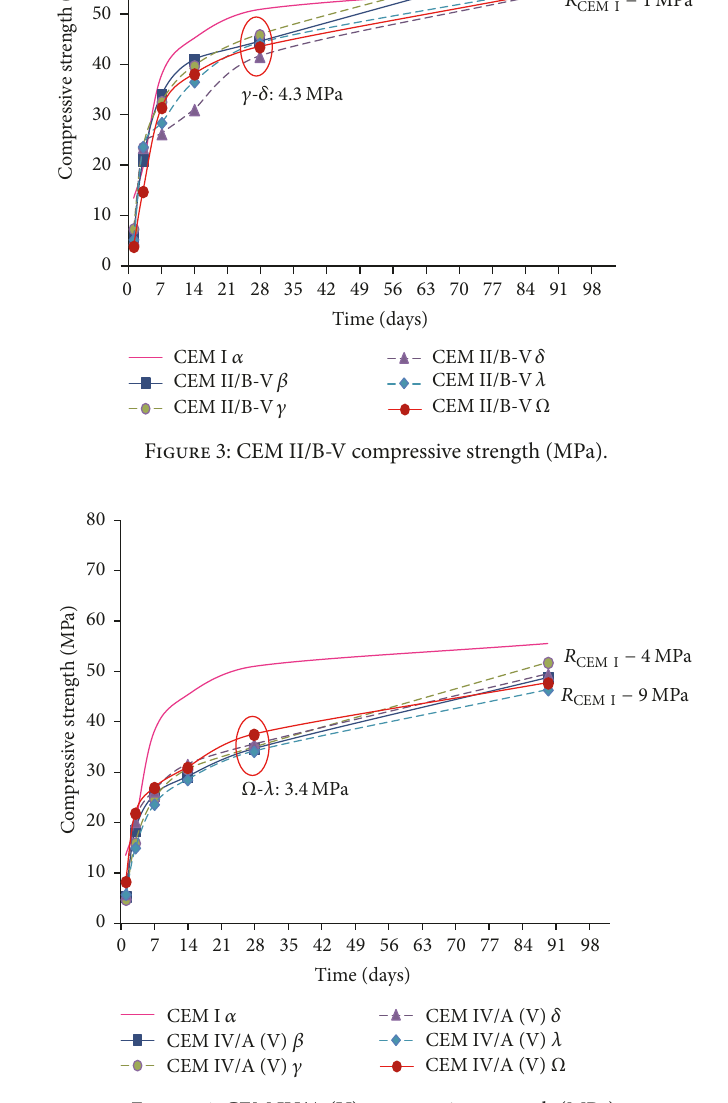
Figure 4: CEM IV/A (V) compressive strength